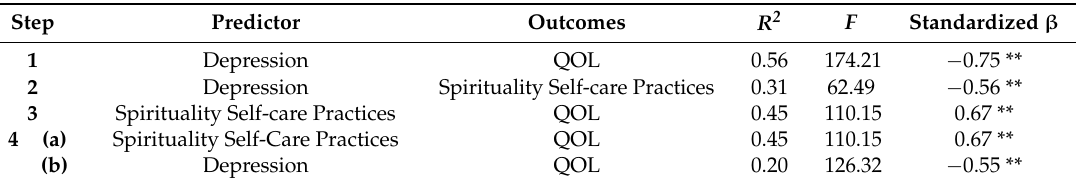
Figure 2. Medication model of spirituality and depression (as measured by PHQ-9) mediated by spiritual self-care practices. Table 4. Mediation analysis of the mediating role of spiritual self-care practices on the relationship between depression as measured by the PHQ-9 and quality of life (QOL) ( N =